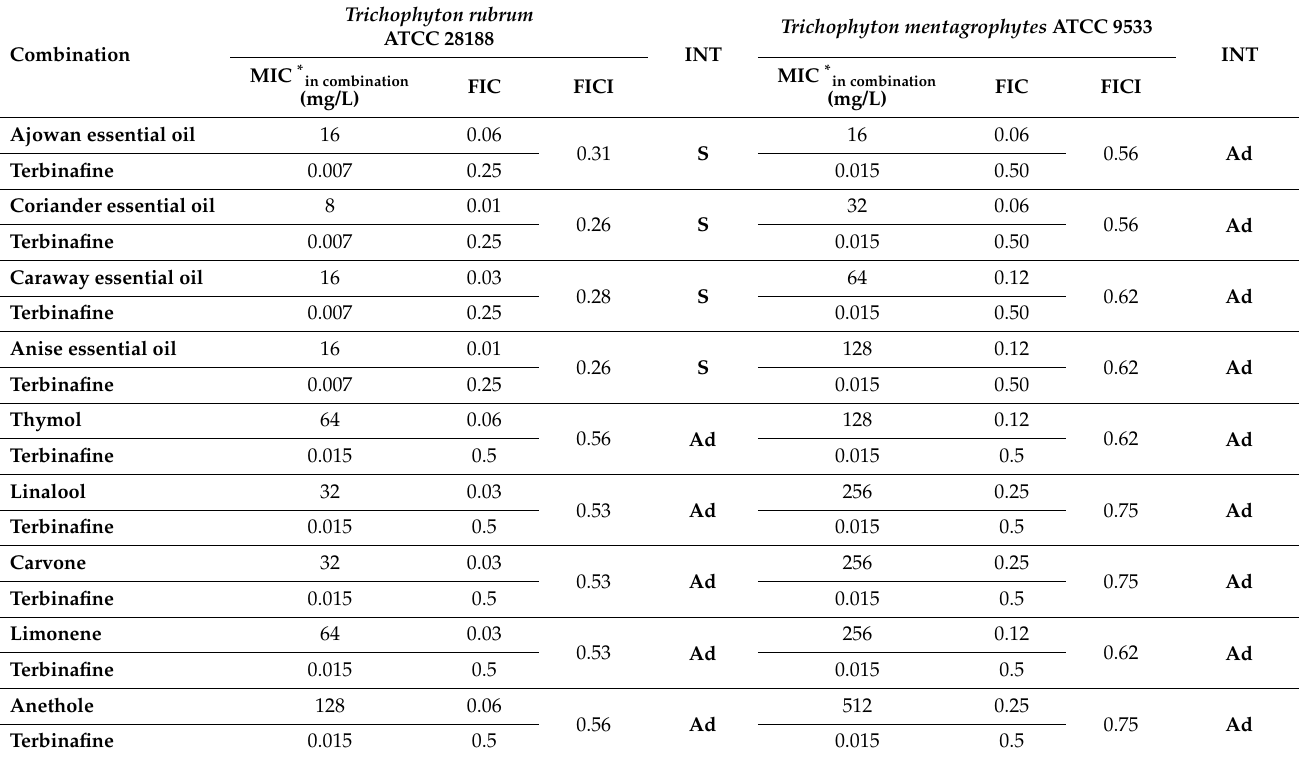
Table 3. Combinatorial effects (FIC and FICI values) between Apiaceae essential oils/main constituents and terbinafine assessed by checkerboard